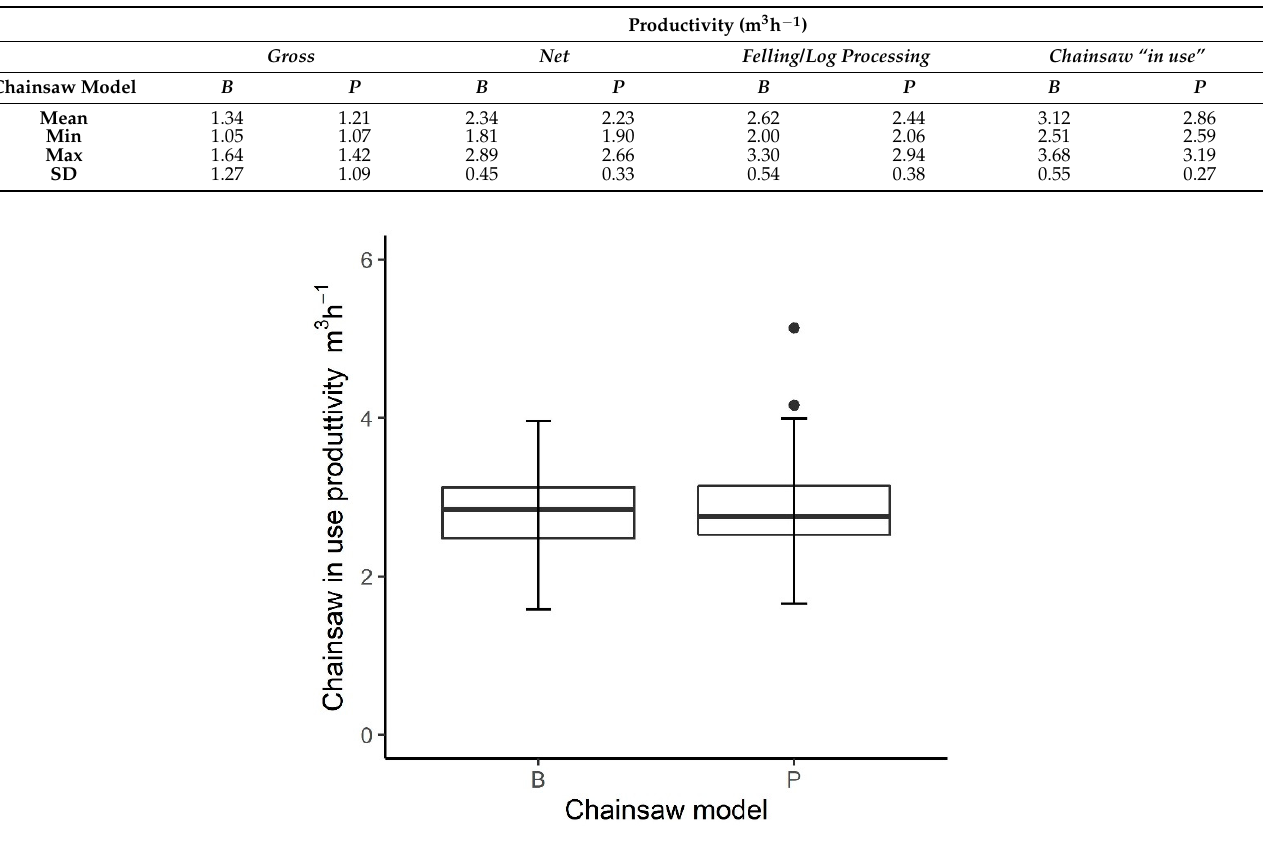
Table 6. Summary of all daily productivities (gross, net, felling, and processing, and chainsaw “in use”) with mean, maximum, minimum, and SD values for each chainsaw model (B = battery MSA220 C-B; P = petrol MS201 C-M).